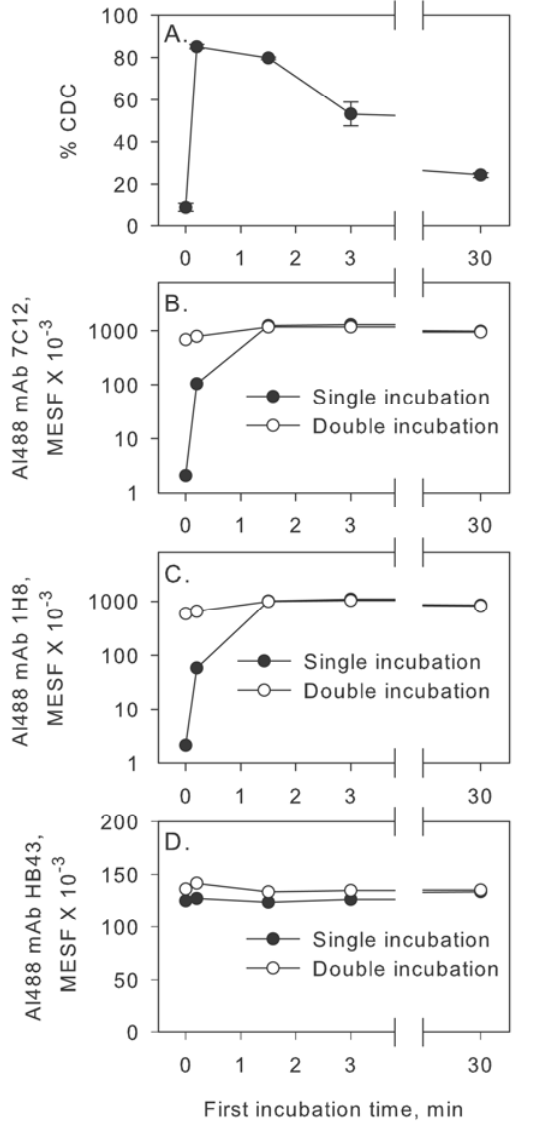
Figure 1. Kinetics of cell-killing reflect the rapid decay of C3b to iC3b. ( A ) Z138 cells opsonized with 10 µg/mL ofatumumab (OFA) were first incubated in 50% C5-depleted NHS for varying times as indicated. The second incubation in 50% NHS supplemented with 10 mM EDTA (final concentration) for 30 min allows for membrane attack complex (MAC) formation on cells with sufficient levels of C3b, but does not permit additional C3b deposition. Thus, the reduction in the % complement dependent cytotoxicity (CDC) is due to the decay of cell-associated C3b to non-functional iC3b. ( B , C ) The initial treatment with C5-depleted serum results in rapid covalent deposition of C3b/iC3b on almost all available sites. A second incubation with C5-depleted NHS does not increase the level of C3b/iC3b as demonstrated by interrogation with two mAbs specific for C3b/iC3b (mAb 7C12) and C3b/iC3b/C3d (mAb 1H8). ( D ) The amount of cell-bound opsonizing mAb (OFA), as detected by mAb HB43, remains constant during these